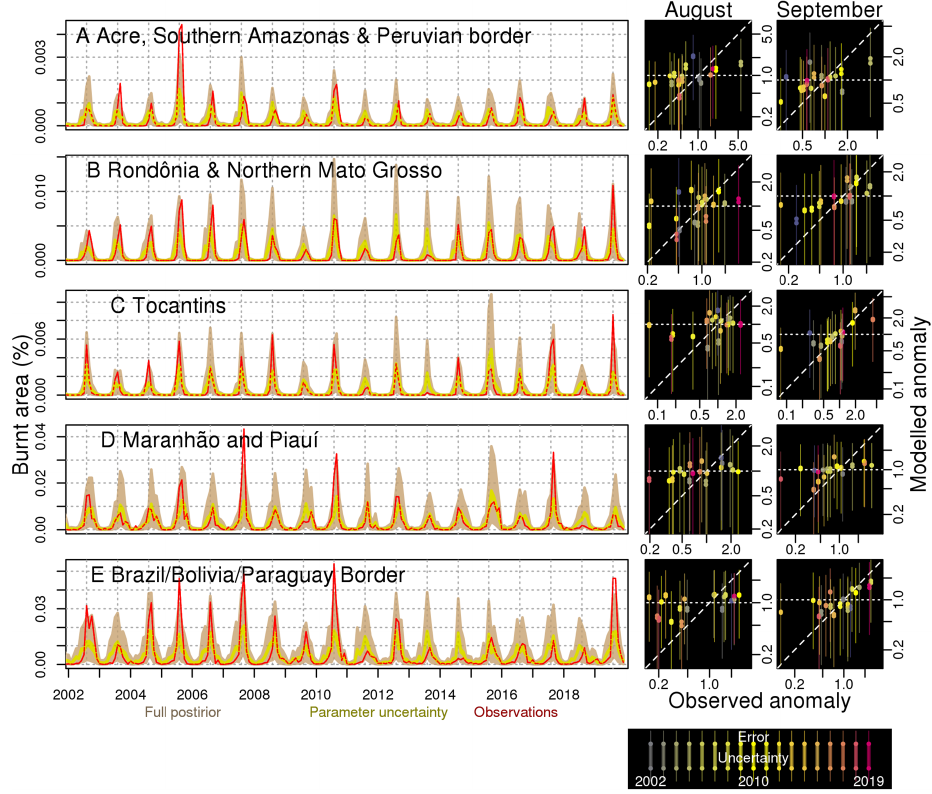
Figure 1. Time series and fire season anomalies for modelled and observed burnt area. See Fig. A2 for locations of A–E. Red lines show monthly burnt area observations from MCD64A1, yellow shows model accounting for parameter uncertainty (10%–90%) and brown shows full model uncertainty (10%–90%). The red line is dashed when observations and model accounting for parameter uncertainty overlap. Vertical grid lines are positioned for August each year. Right-hand plots show observed ( x axis) and modelled ( y axis) anomaly, calculated as 2019 burnt area over 2002–2019 climatological average burnt area for (first column) August and (second column) September. The colour indicates the year, with 2019 in red. Thin lines show 10%–90% full model uncertainty, while dots and thick line indicate 10%–90% parameter